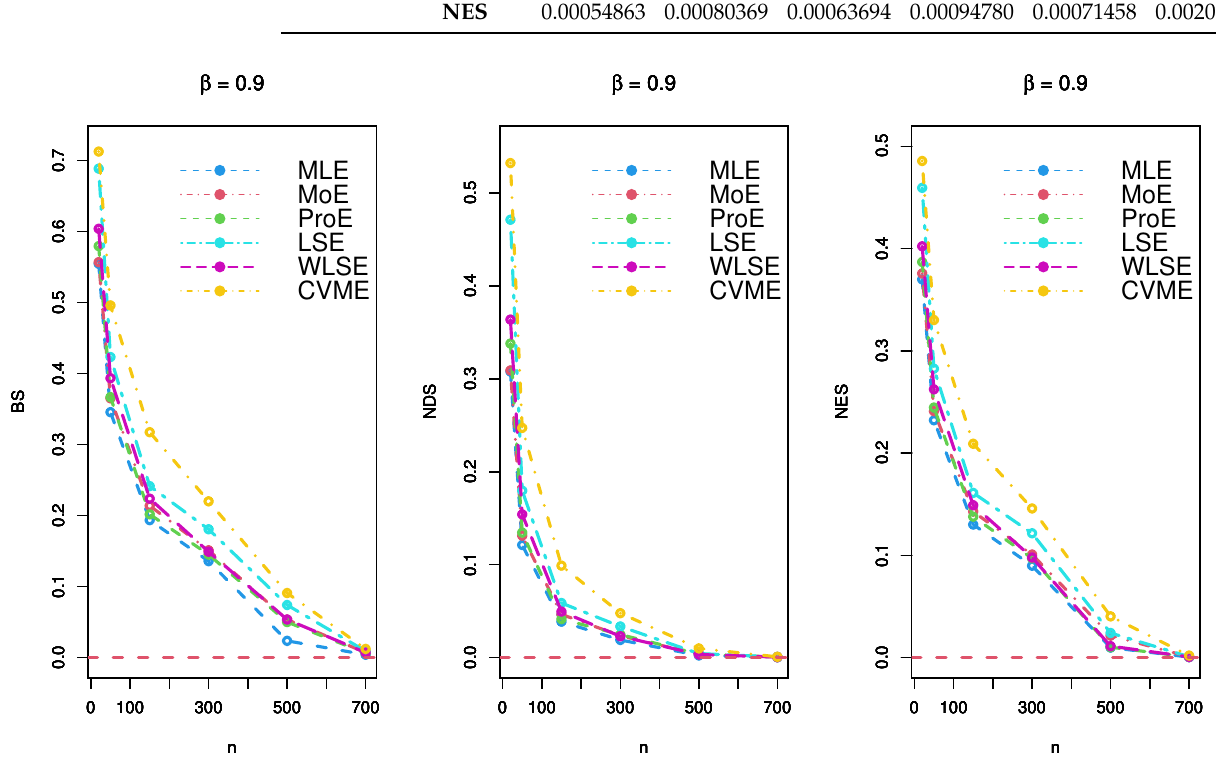
Figure 5. Simulation results for β = 0.9 under various estimation